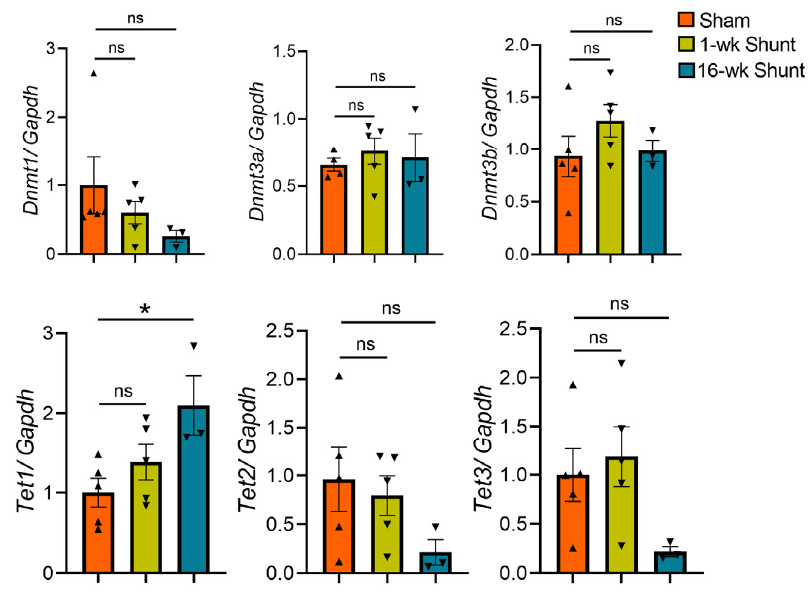
Figure 8. Quantitative real-time PCR of Dnmts and Tets enzymes. Values are mean ± SEM, n = 3–5 hearts/group. * p < 0.05 vs. sham, two-tailed unpaired Student’s t -test. n.s., not significant.